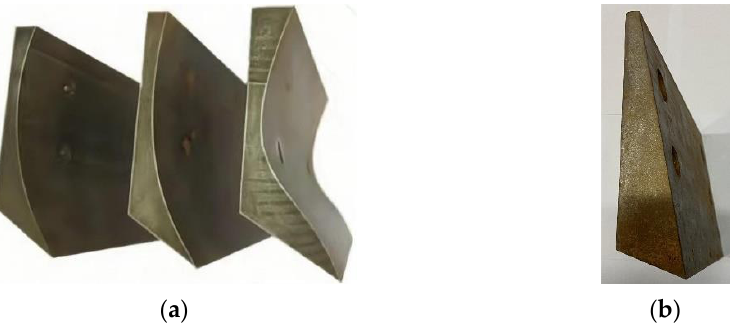
Figure 9. Test bulldozing plate models. ( a ) Three curved bulldozing plates. ( b ) The ruled surface bulldozing plate.